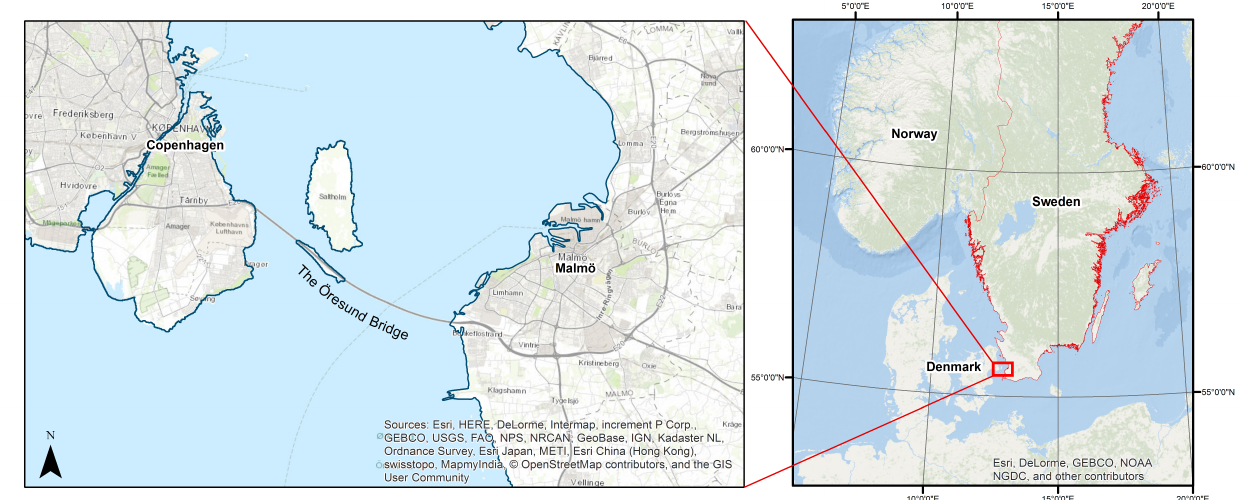
Figure 1. Malm¨o location maps